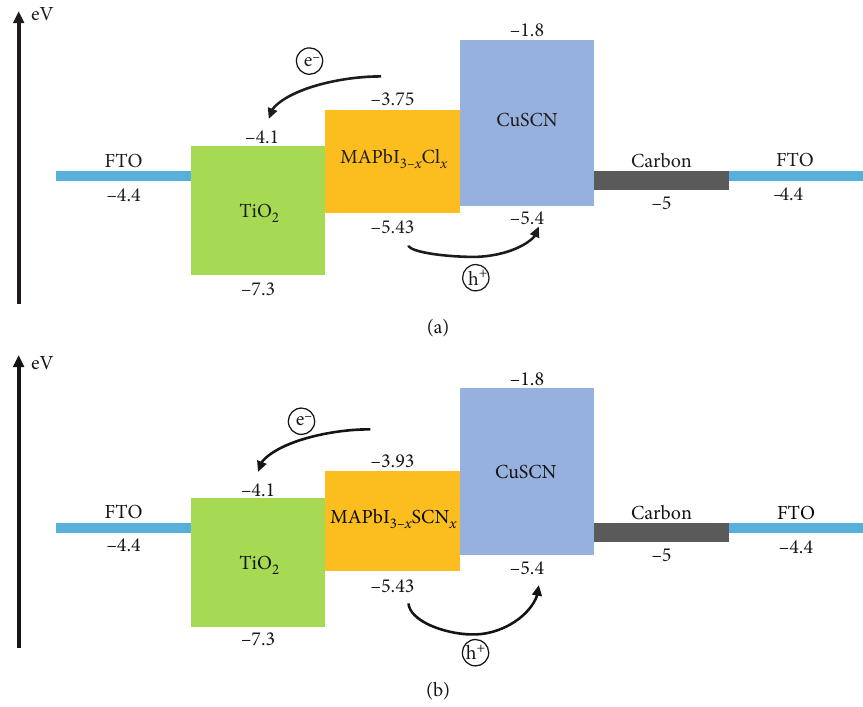
Figure 2: Energy level diagram of perovskite solar cell using (a) CH